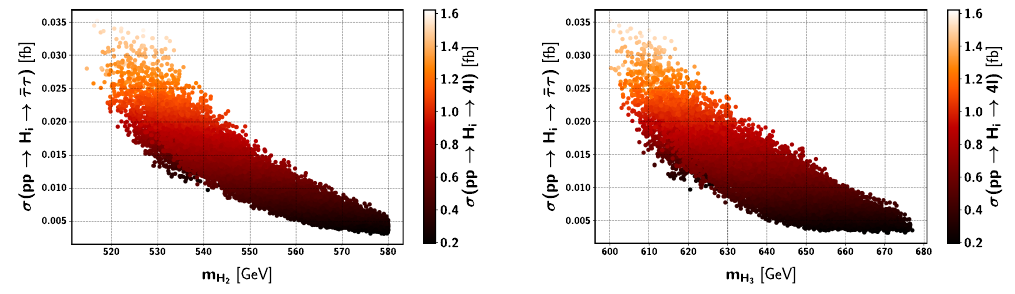
Figure 4 . Results from the very fine-grained parameter space scan for the inclusive production cross section of τ + τ − via H 2 and H 3